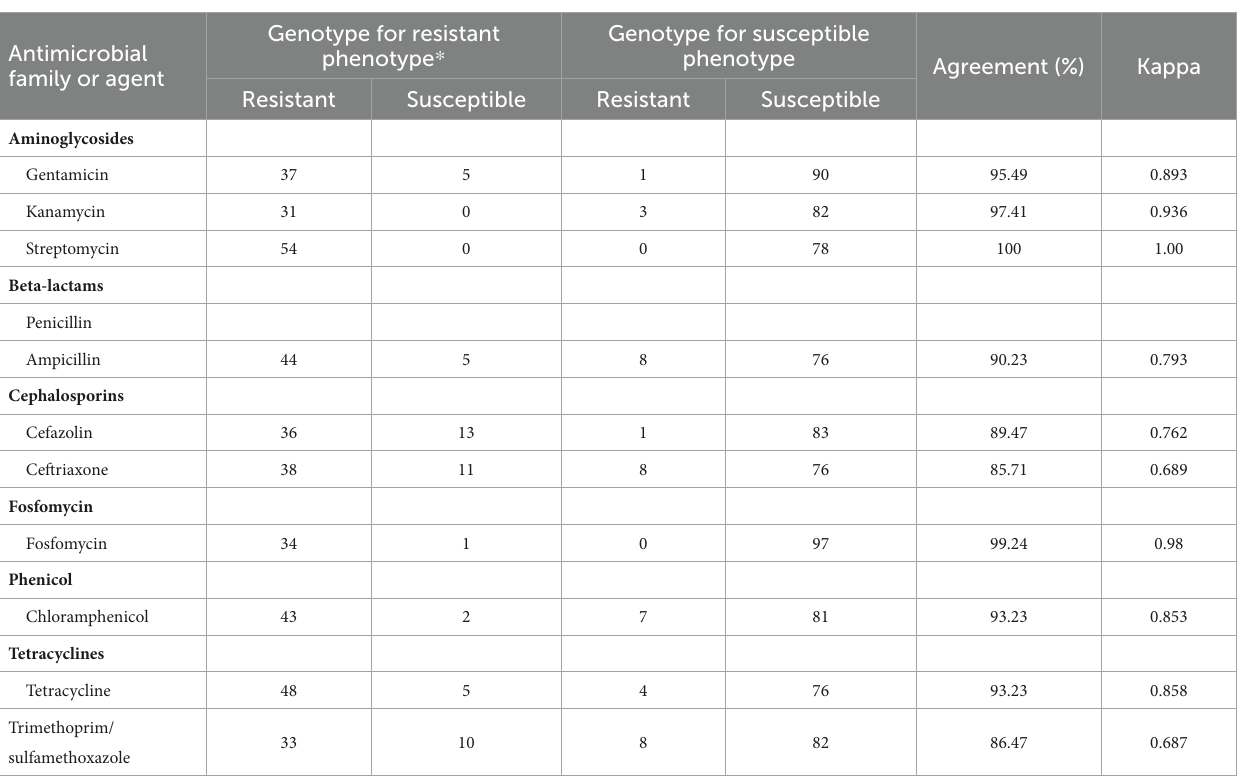
TABLE 4 Agreement between genotypes and phenotypes of Salmonella